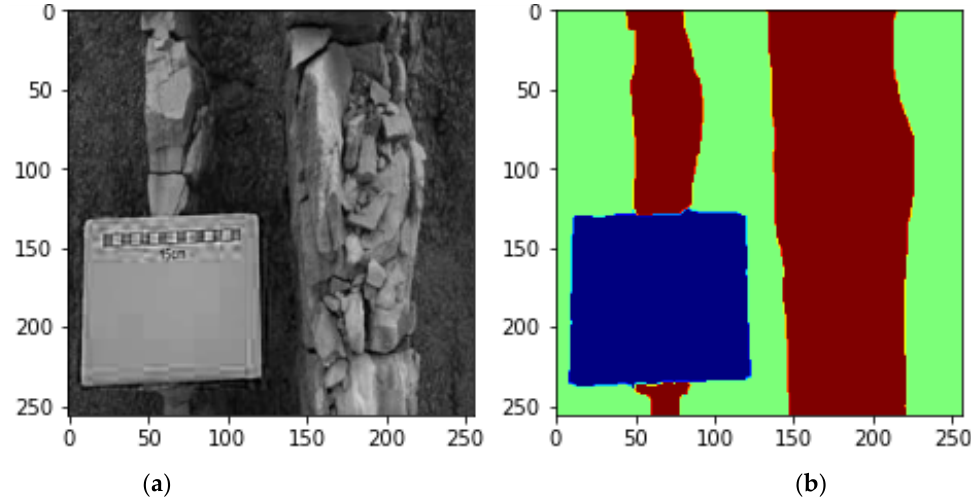
Figure 3. An example of ( a ) an original image and ( b ) its labels—background (blue), mudstone (wine) and sandstone (green).